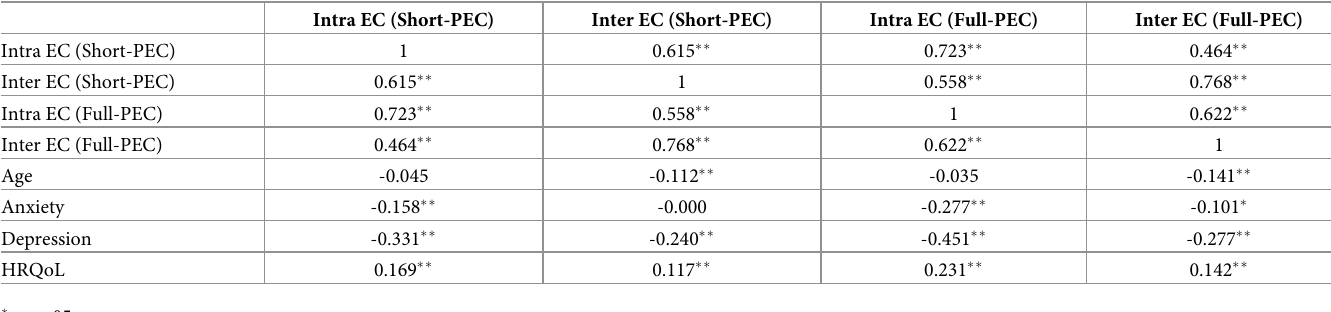
Table 3. Correlations between age, anxiety, depression, HRQoL, and Short- and